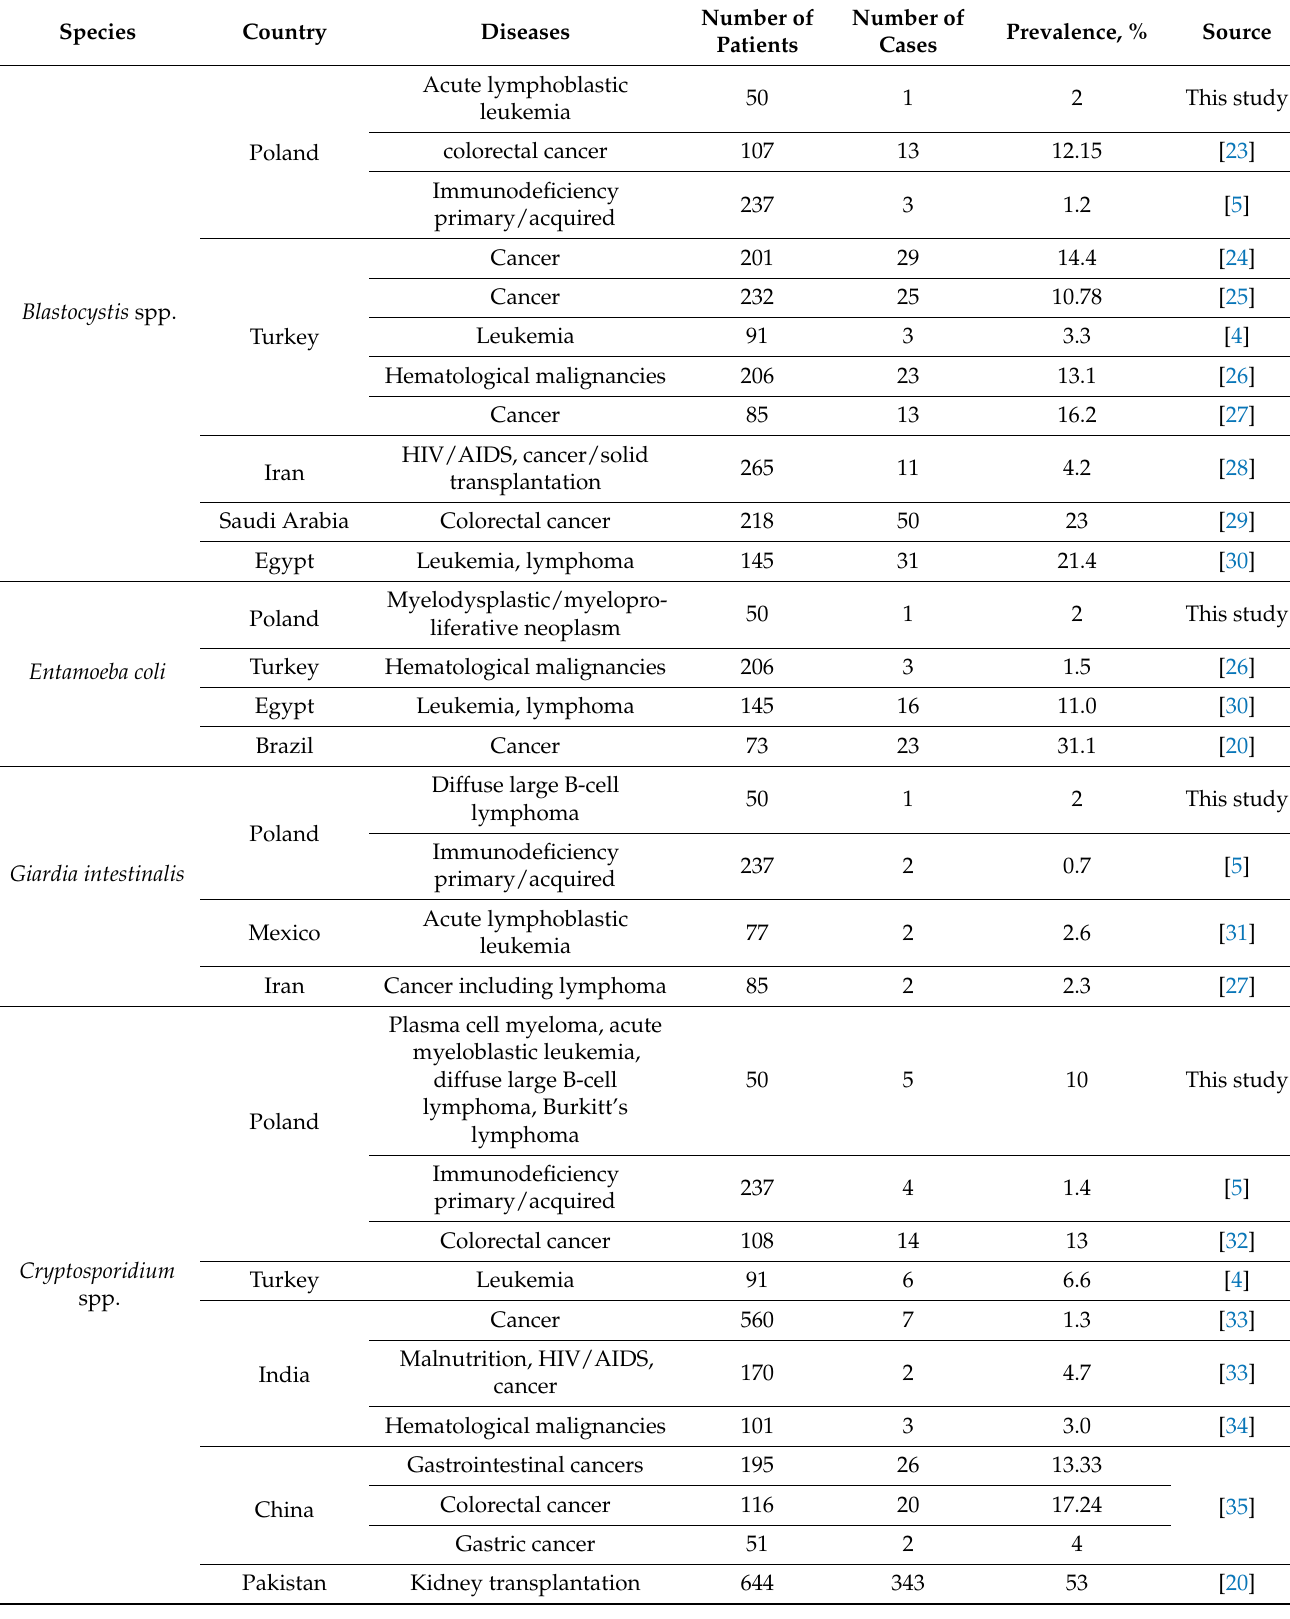
Table 3. The occurrence of intestinal parasites in humans from different part of the world according to immunological